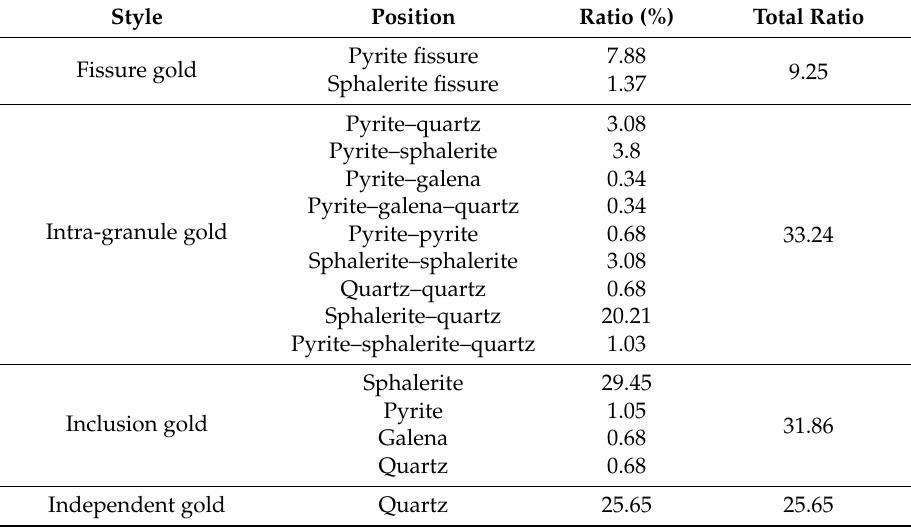
Table 3. Relations among the gold minerals from the Xiajinbao gold